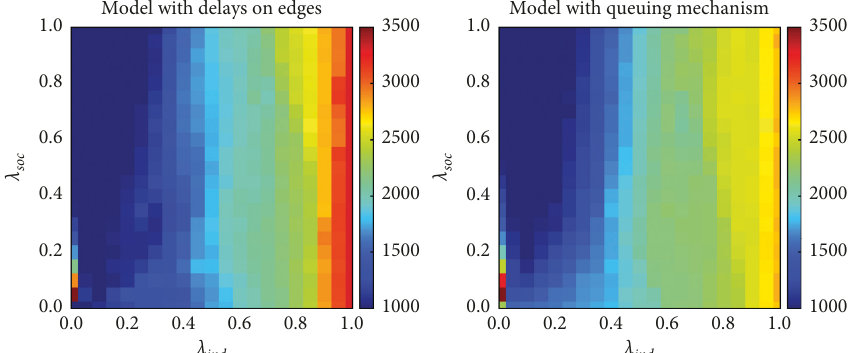
Figure 4: Aggregated results for number of routes changed during the simulation’s run. Each cell corresponds to single combination of λ and λ with value aggregated for all simulation’s iterations which represents average number of routes changed during this soc